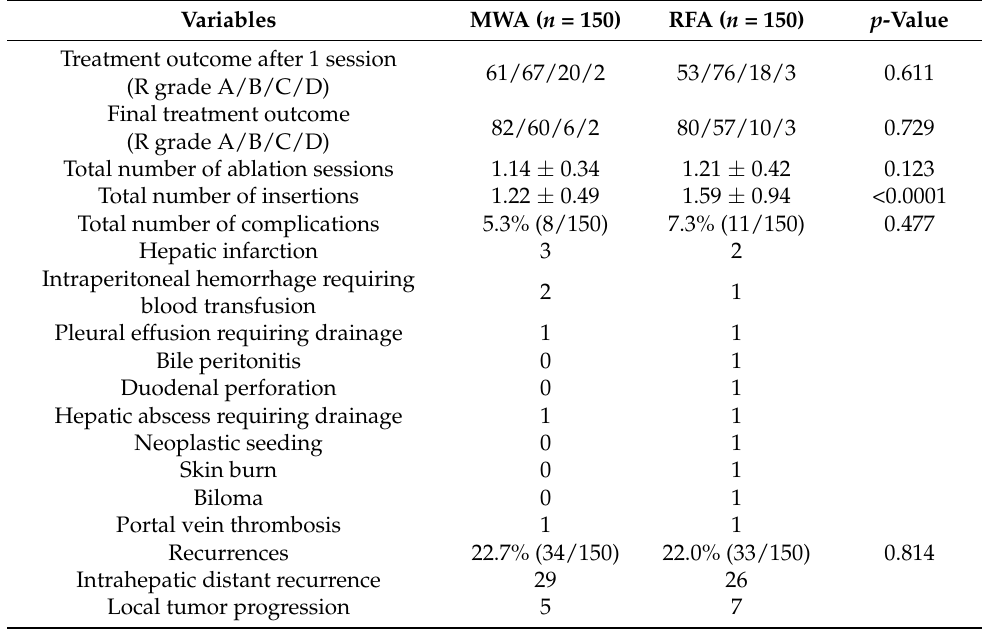
Figure 3. Kaplan-Meier survival curves for overall survival (OS, A ) and recurrence-free survival (RFS, B ) in the PSM cohort. No significant differences were observed between the groups that underwent microwave ablation (MWA) and radiofrequency ablation (RFA). Table 2. Treatment parameters and outcomes in the propensity score-matched